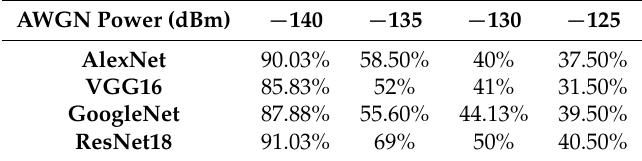
Table 4. The prediction result for AMC2.